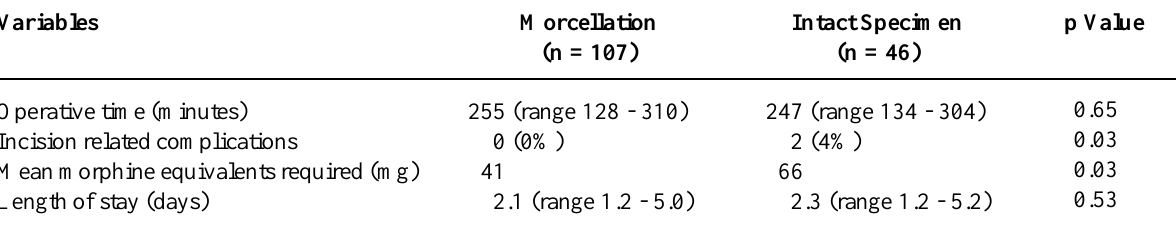
Table 2 – Univariate analysis of the morcellated and intact specimen retrieval groups.